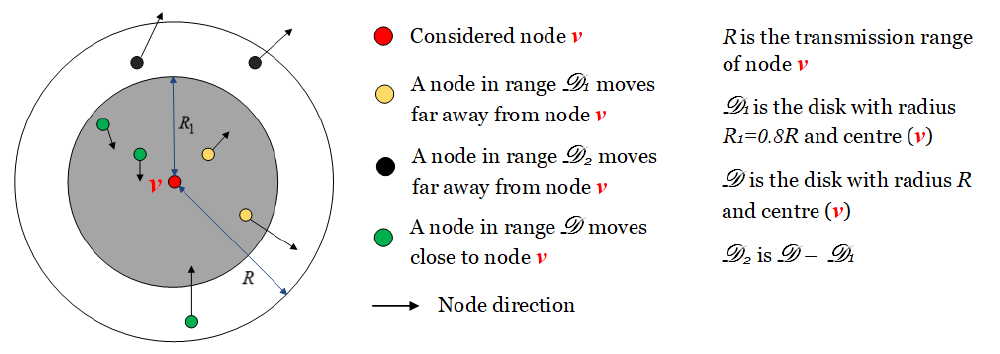
Figure 2. The mobility relationship between two